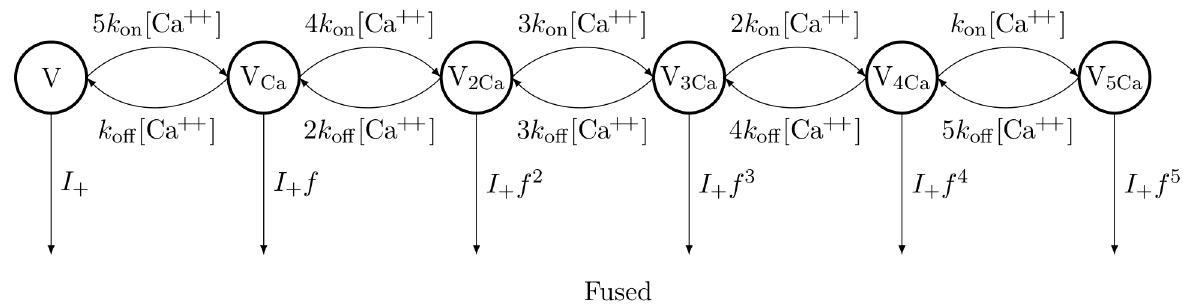
Figure 9. Allosteric model for the instantaneous rate of vesicle release in a Calyx of Held. This model is used to estimate the vesicle release rate as a function of local transient Ca ++ concentration. Transition rates between states depend on Ca ++ local concentration in the vicinity of the vesicles. The release probability is higher the more Ca ++ ions are bound to the vesicle, according to a factor f =31.3. The base rate constant I + is set to 2 6 10 2 4 s 2 1 .